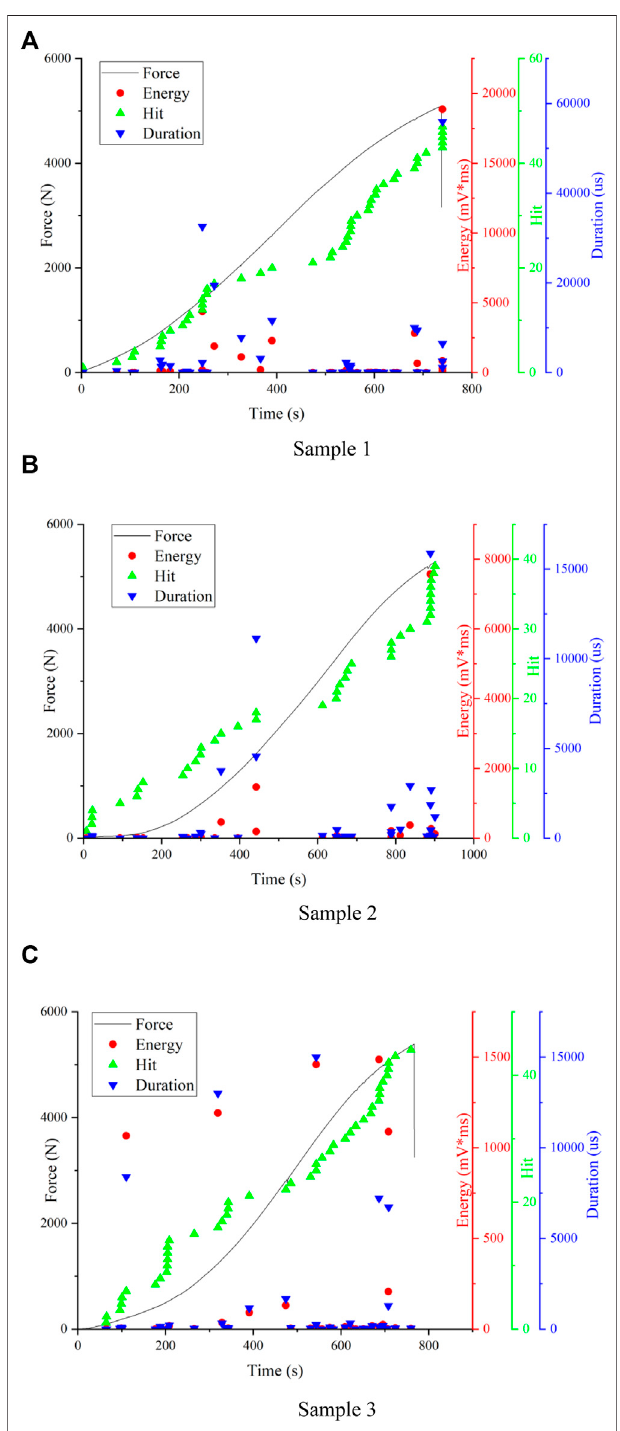
FIGURE4| Force/energy/hits/durationtime. (A) sample1; (B) sample2; (C) sample 3.